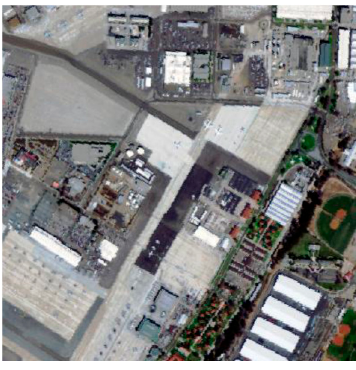
Figure 8. AVIRIS Hyperspectral Image.